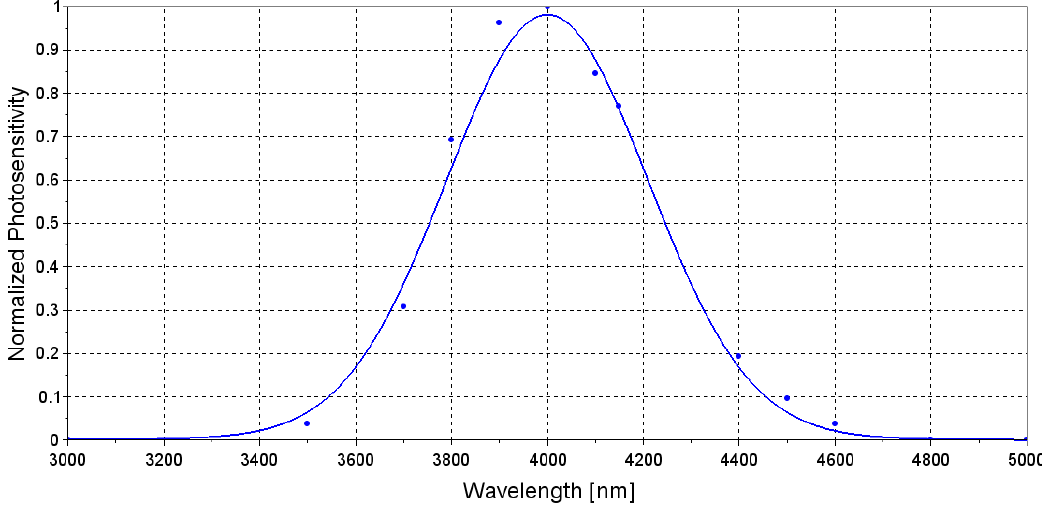
Figure 8. Simulated PD spectral response (solid line) and data provided by the manufacturer (dots)